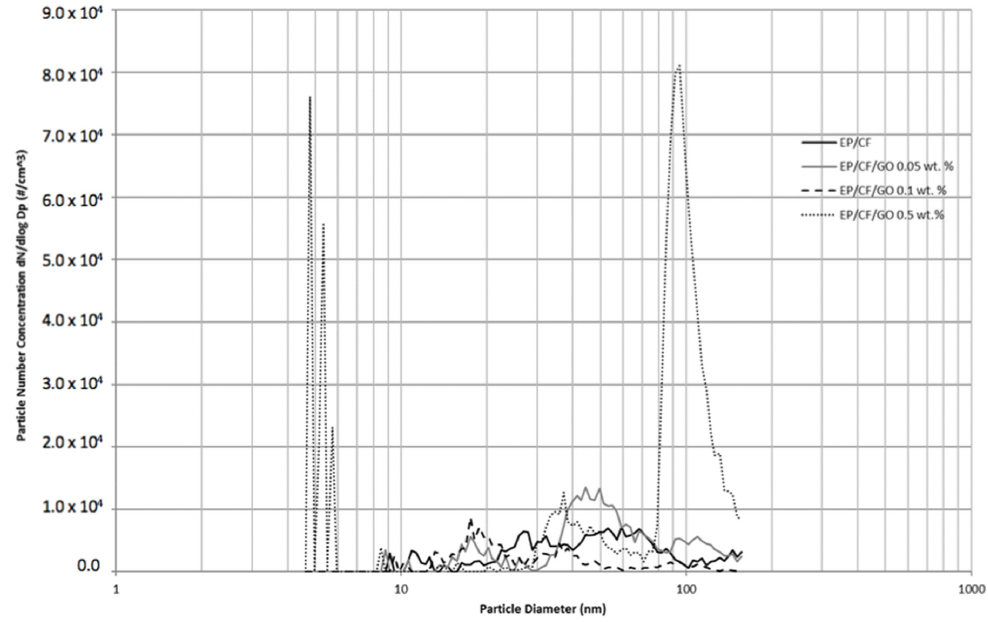
Figure 5. Average particle size distribution measured using scanning mobility particle sizer (SMPS) of EP/CF-based nanocomposites reinforced with GO (n = 12 for each average).